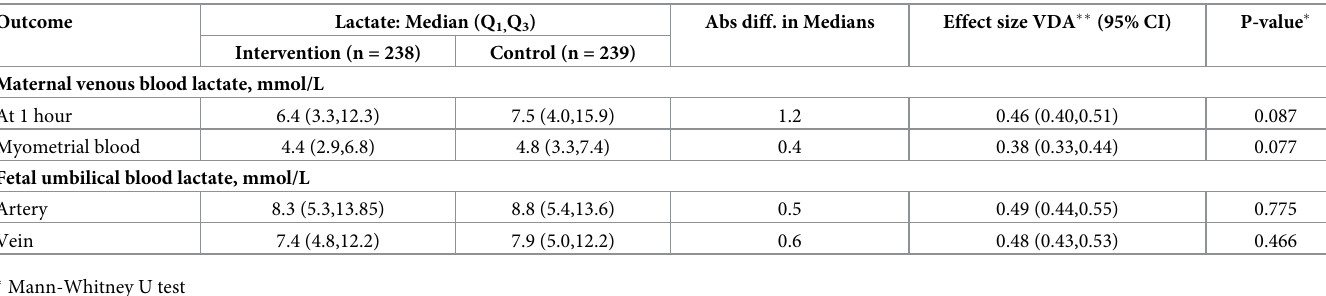
Table 2. Blood lactate results among women in the intervention and control groups. Data presented as means (95% CI), N = 477.